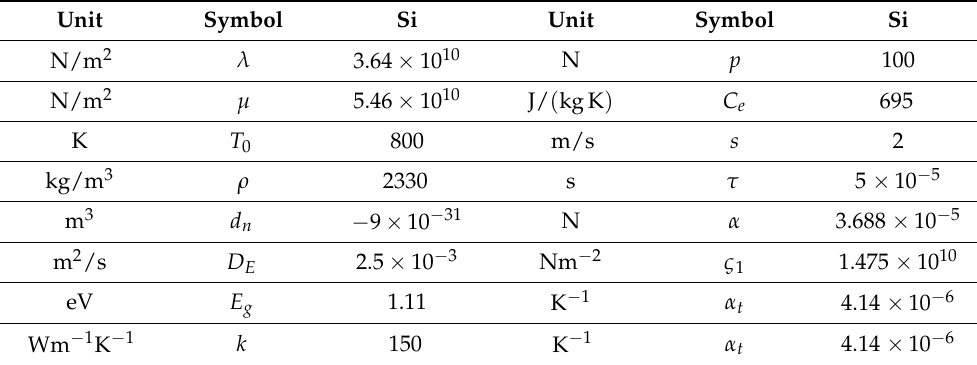
Table 1. The physical constants of the Si